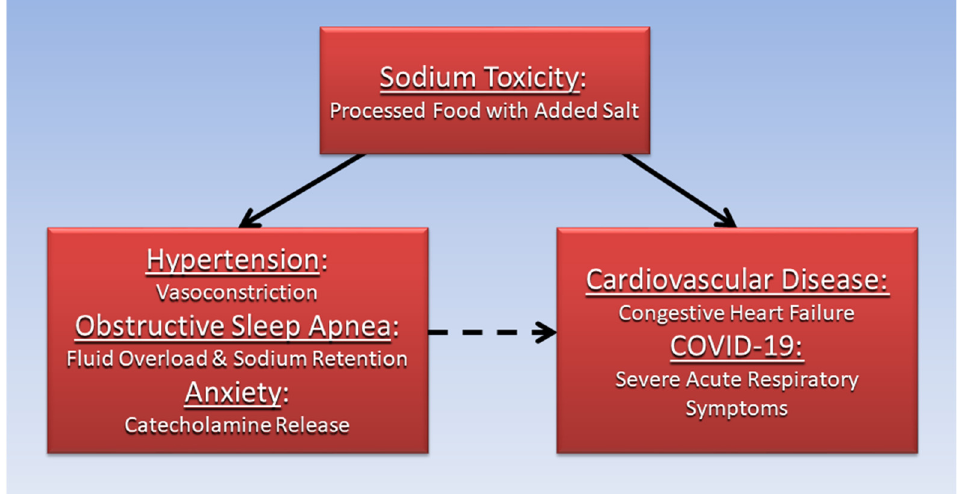
Figure 2. High salt diet and sodium toxicity mediates the association of hypertension, anxiety, and obstructive sleep apnea with cardiovascular disease and COVID-19.